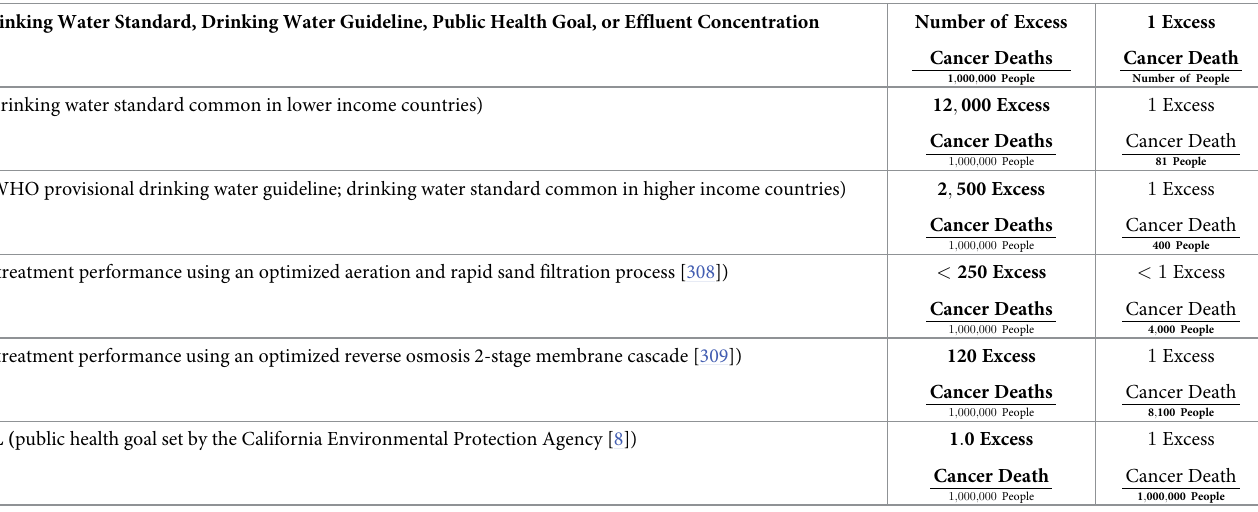
Table 5. Common drinking water standards, guidelines, and public health goals for total arsenic (As) in micrograms per liter ( μ g/L), the effluent concentrations of total As in μ g/L from water treatment systems used in the high-income world, and the estimated cancer risks at these concentrations (Eqs 1, 2, 3, 4, 5 and 6). These cancer risks are in bold font and rounded to 2